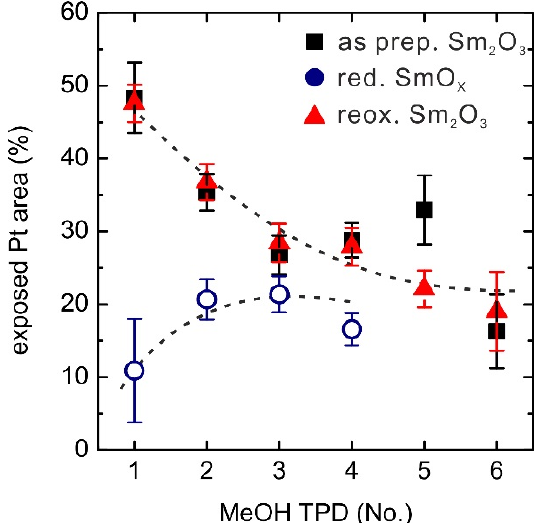
Figure 9. Changes of exposed Pt areas (%) on the 0.9 ML SmO x /Pt(111) samples over repeated TPD experiments. The dashed lines are added as a guide to the eye.